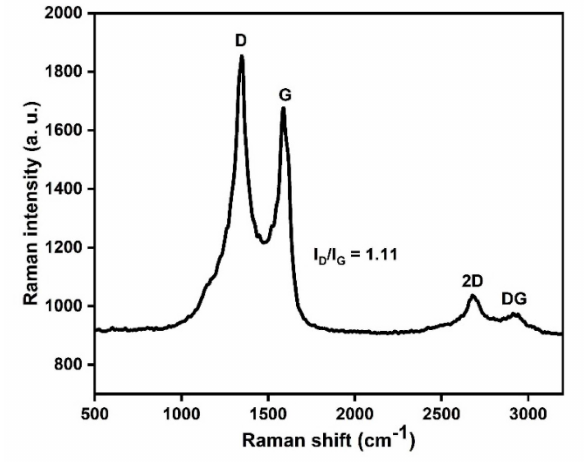
Figure 3. Raman spectra of the OMSC catalyst.